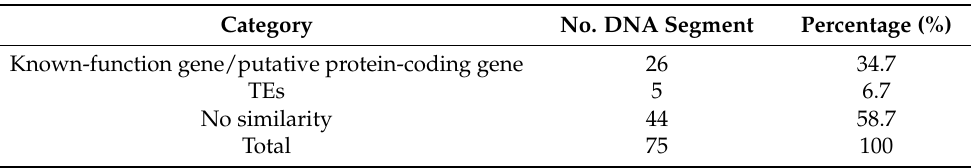
the fruit tree cultivars based on the MSAP profile. Category No. DNA Segment Percentage